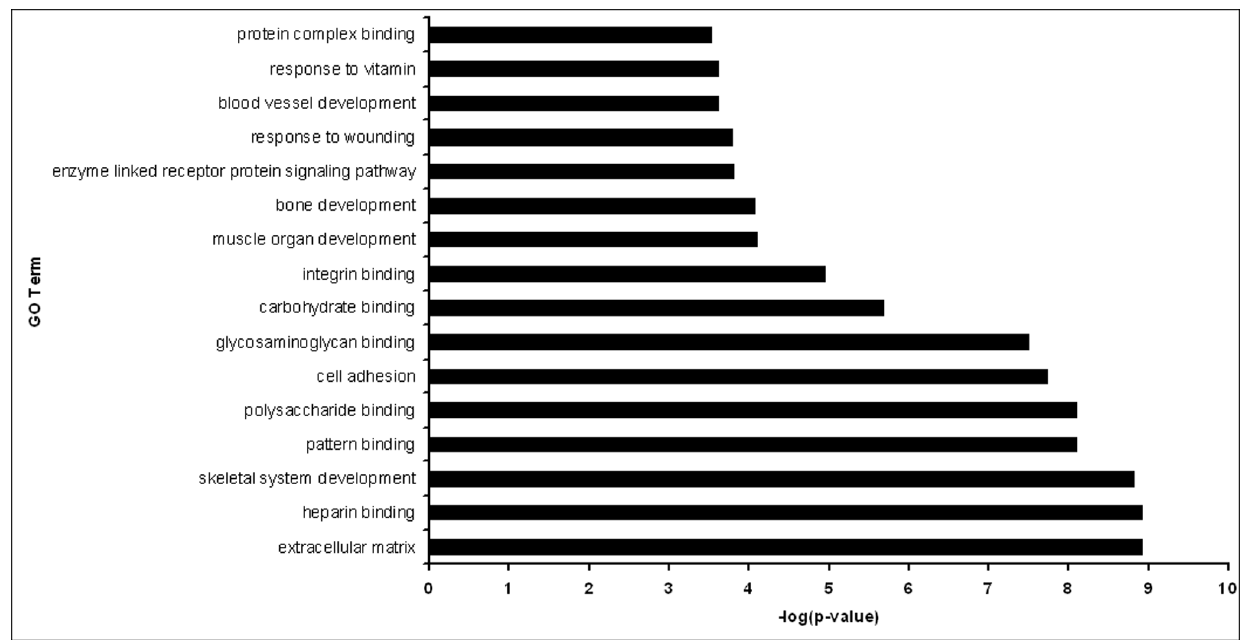
Figure 5. Gene ontology analysis of preferentially expressed signature limbal genes. Bar graph showing significance of enrichments terms from preferentially expressed genes in the limbal tissue.